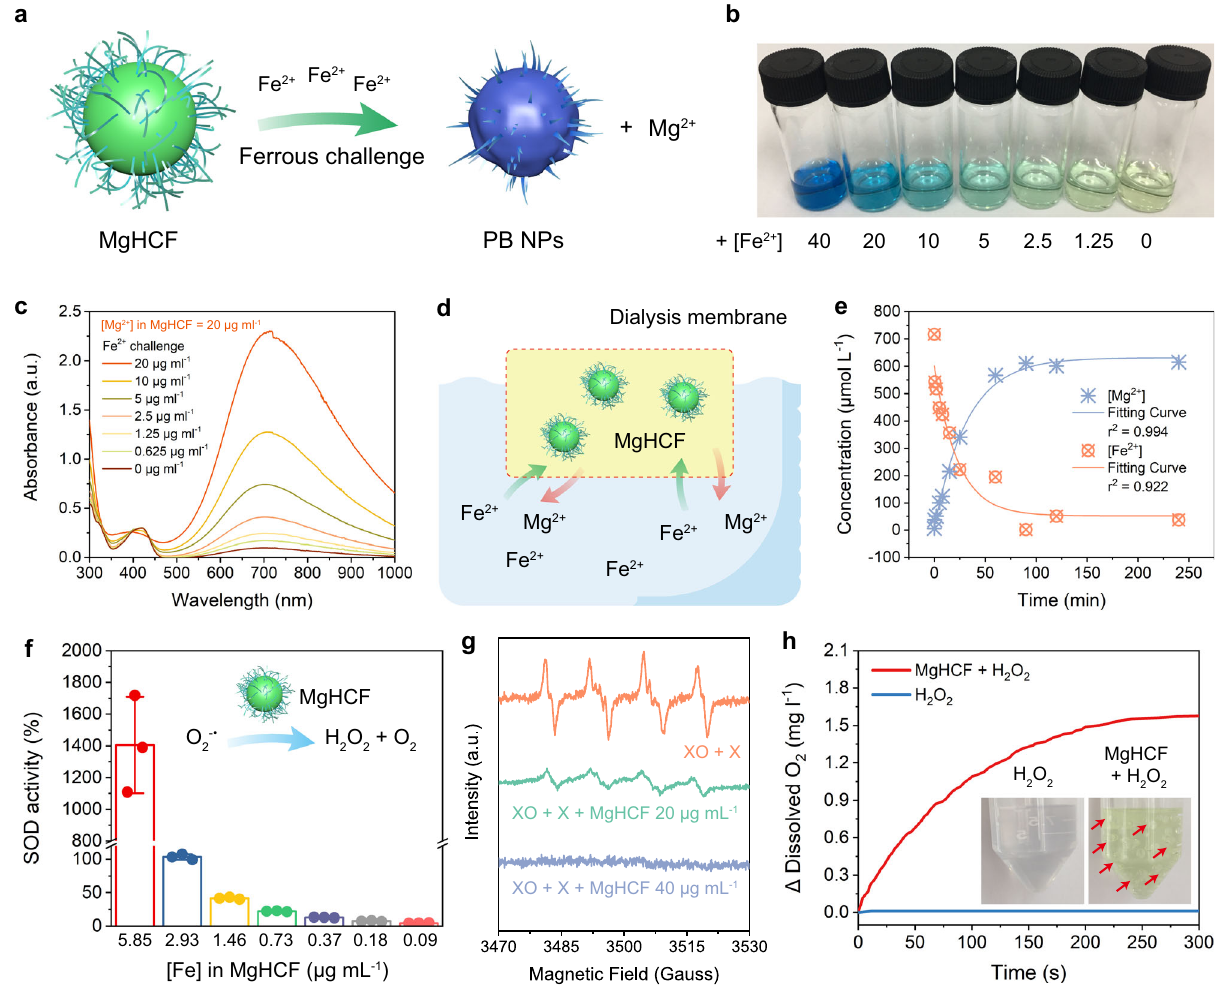
Fig. 3 | Ferrous capturing and antioxidation performance of MgHCF NCs. a SchematicillustrationoftheferrousbindingactivityofMgHCFasaPrussianblue analogue by recovering to the pristine Prussian blue nanoparticles. b Digital pho- tograph ofthe aqueous solutions containing MgHCF NCs with the additions ofthe ferrous ions at varying concentrations. c Corresponding UV – vis spectra of respective samples in ( b ). d Schematic illustration of the dialysis-membrane separation-regulated cation exchange for MgHCF NCs. e Time-dependent ele- mental concentration pro fi les for Mg 2+ and Fe 2+ in the solution during the dialysis-